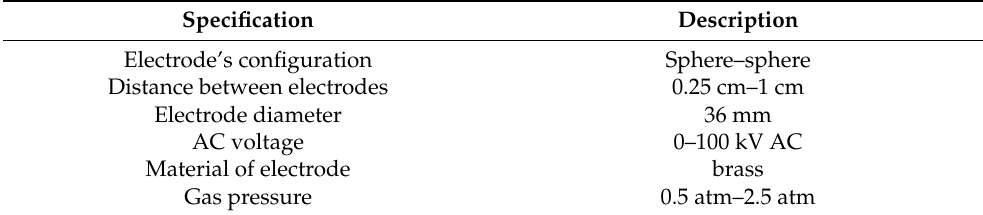
Table 4. Experimental Conditions.